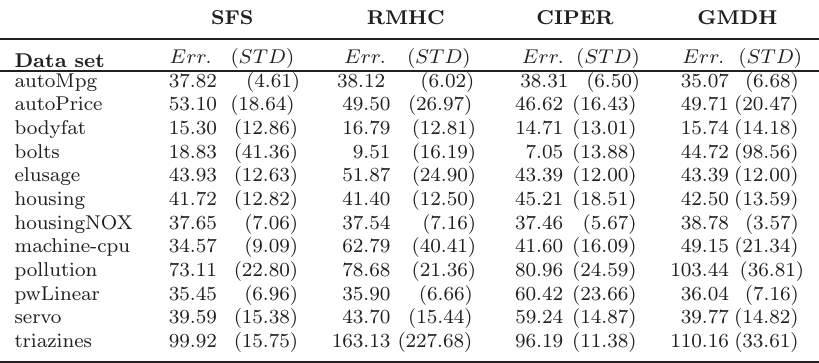
Table 2. Average RRMSE (%) and its standard deviation of the induced models.